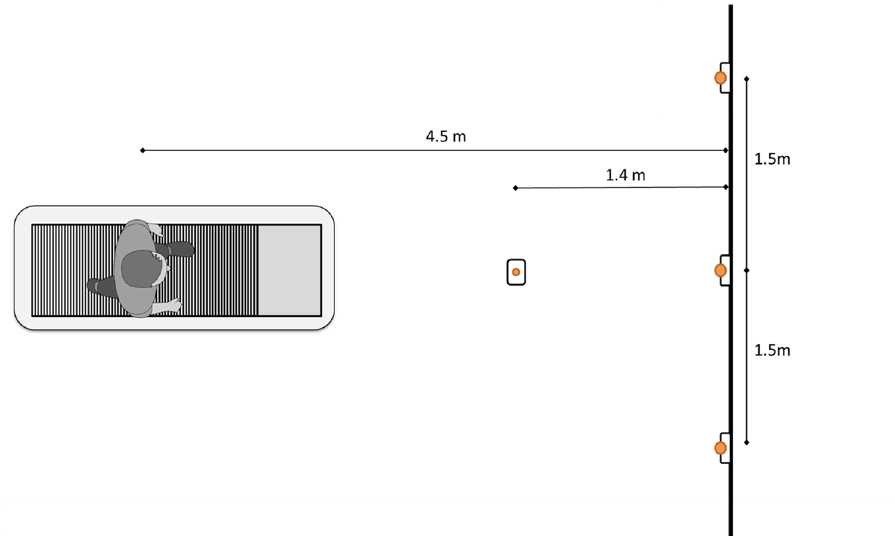
Figure 4. Top view of experimental set up. Three right LEDs are mounted on a wall at approximate eye-height from the treadmill. The LED positioned between the treadmill and the wall was positioned on the ground, at a distance that represents approximately 2 steps ahead from the centre of the treadmill. Horizontal plane head rotation (yaw) required for a movement between the most lateral LEDS is about 37°. Sagittal plane rotation required from the ground LED to the wall mounted LEDs is about 49°. Exact angles depend on participant height and precise position on treadmill.